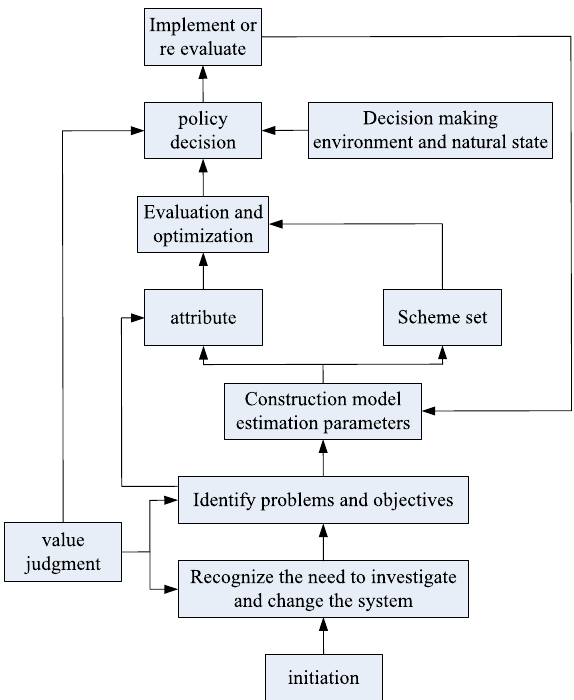
Fig. 5 The solution process diagram of multi-objective